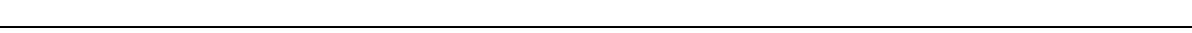
(Fig. 3g, second row: blue; third row: green). In humans, decision-